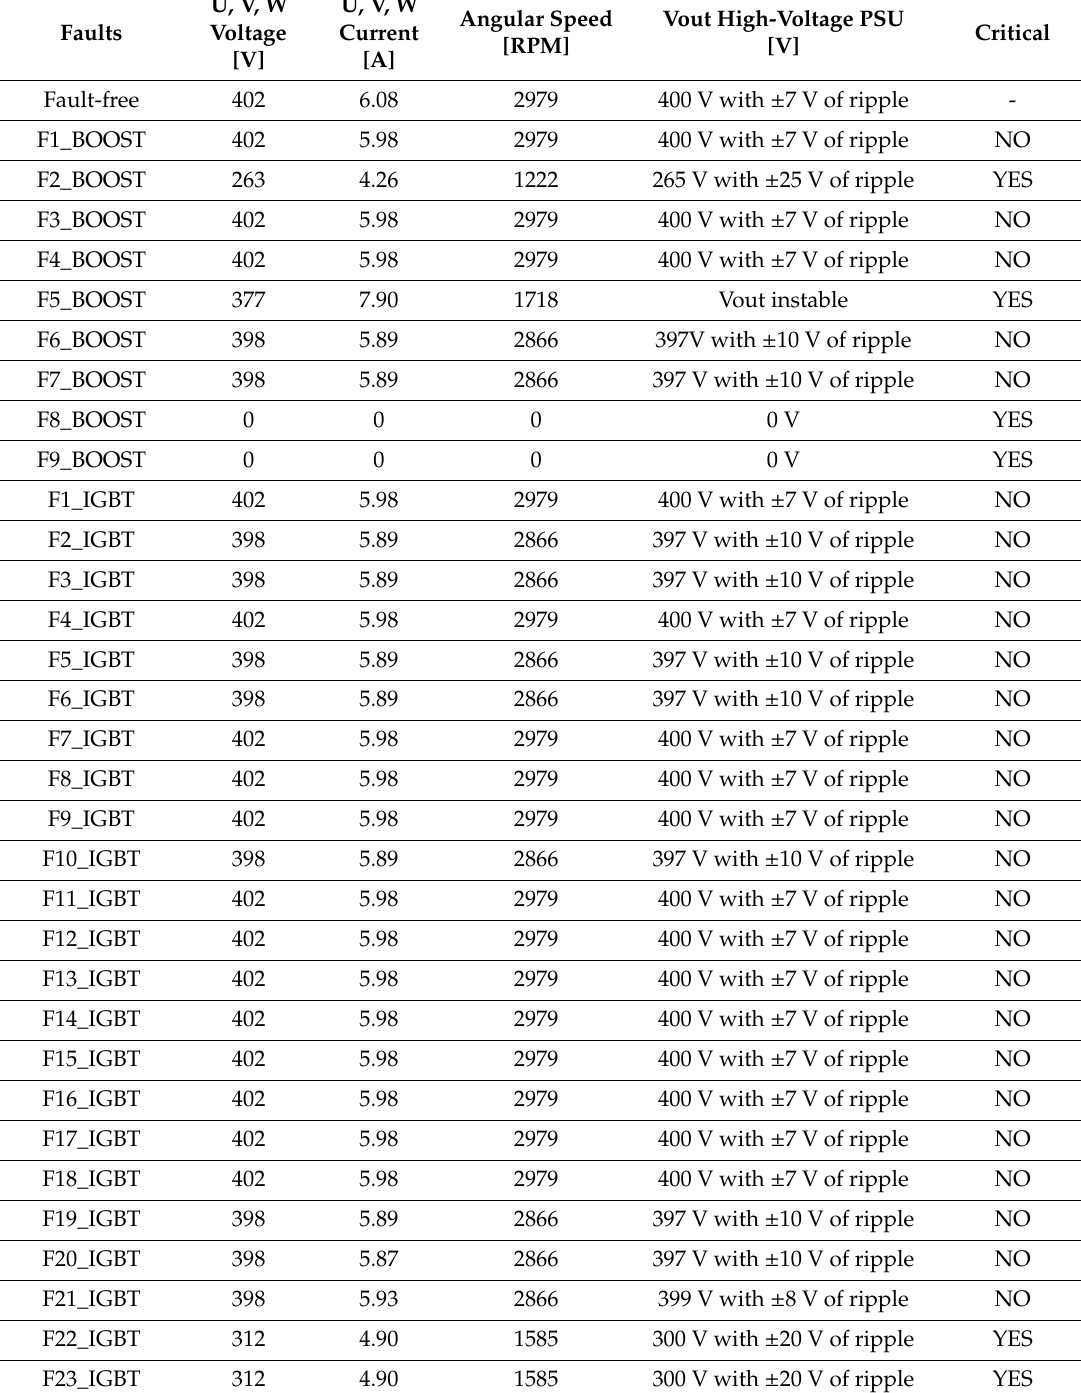
Table 2. Critical fault